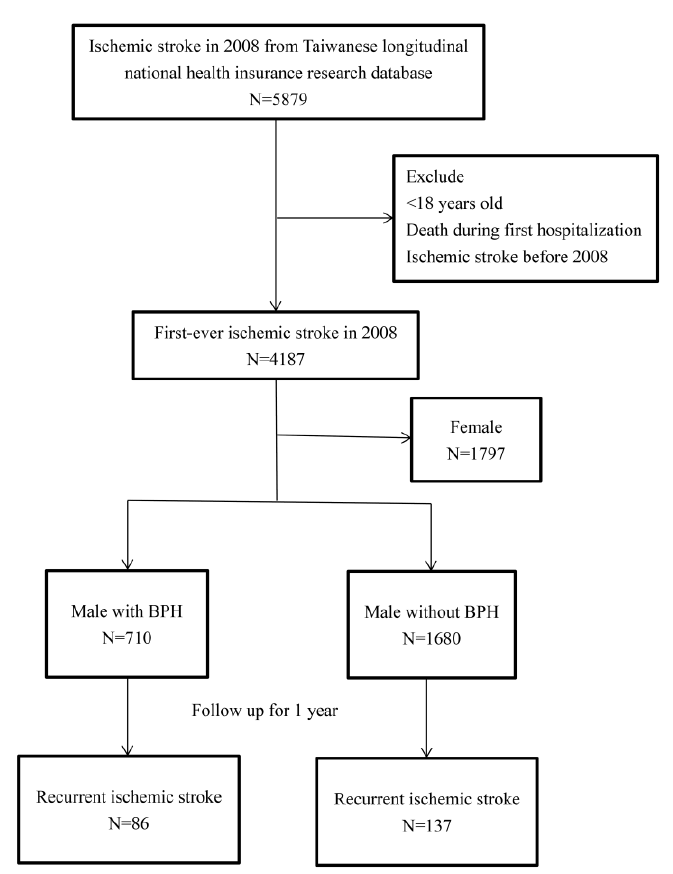
Figure 1. The flowchart of this study. BPH: benign prostatic hyperplasia.